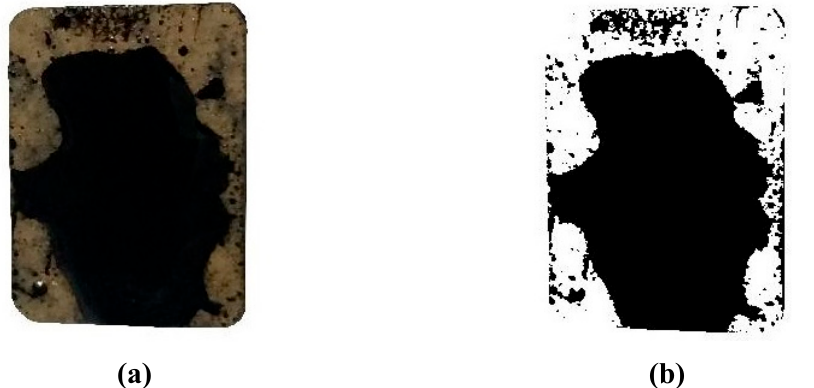
Figure 7. The image processing of test specimens with #110 asphalt and granite aggregate: ( a ) original image and ( b ) binary image.